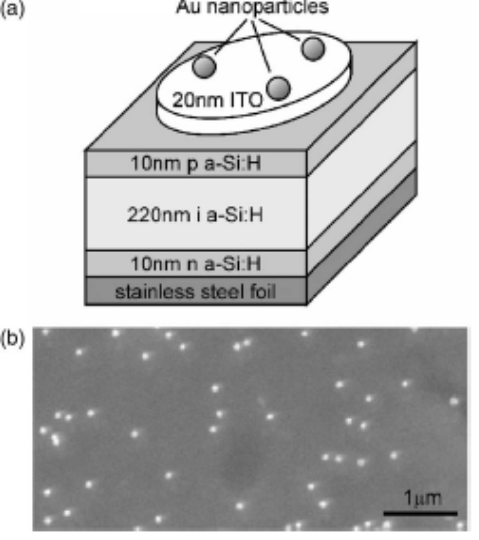
Figure 12. (a) Schematic diagram of a-Si:H p-i-n SC structure with Au nanoparticles. (b) SEM image of 100-nm-diameter Au nanoparticles deposited on device surface (reprinted with permission from [45]. © 2006, American Institute of